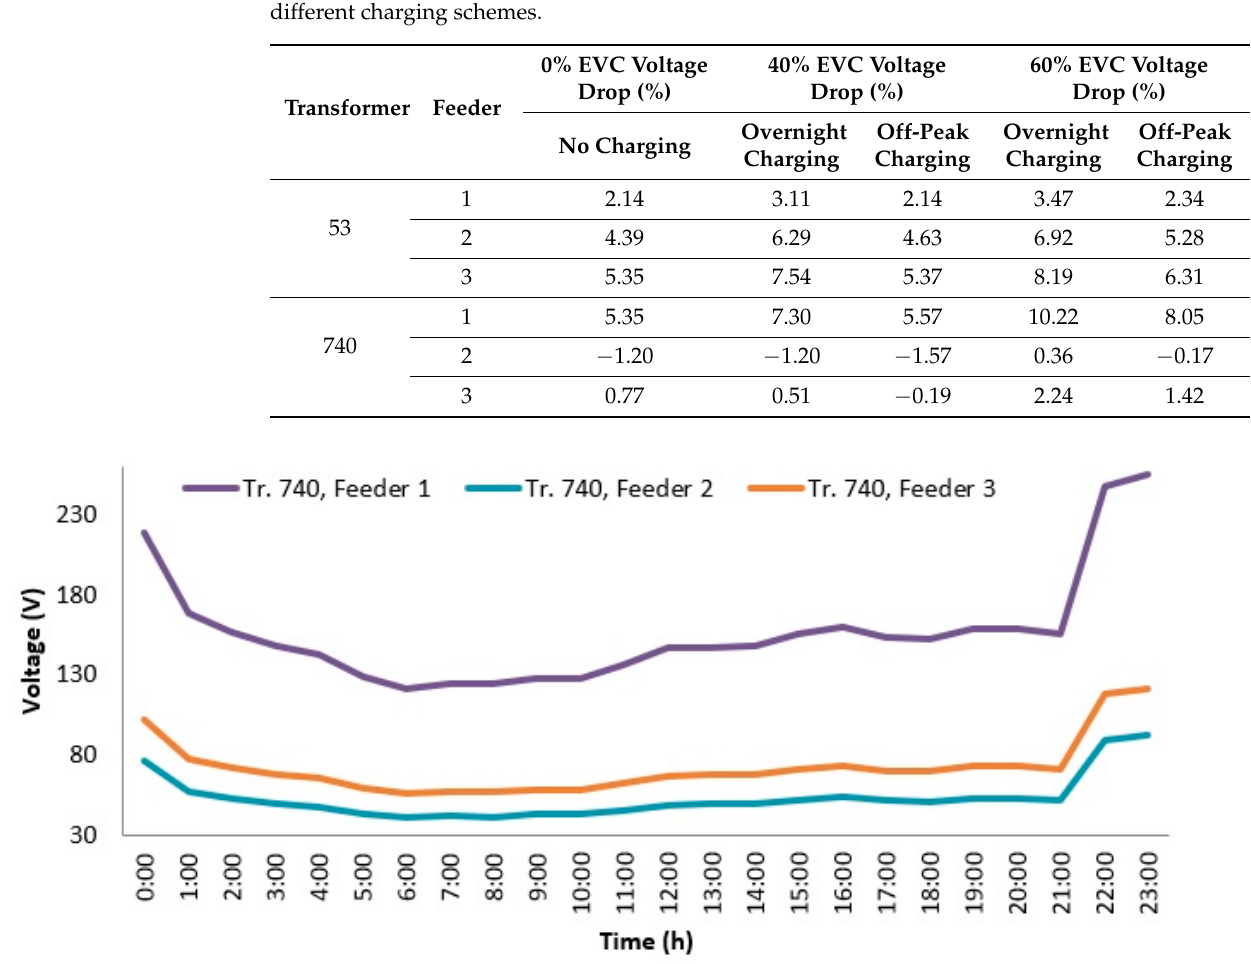
Figure 15. Load Profiles of Transformer 740 in summer with 60% EVC and overnight charging.